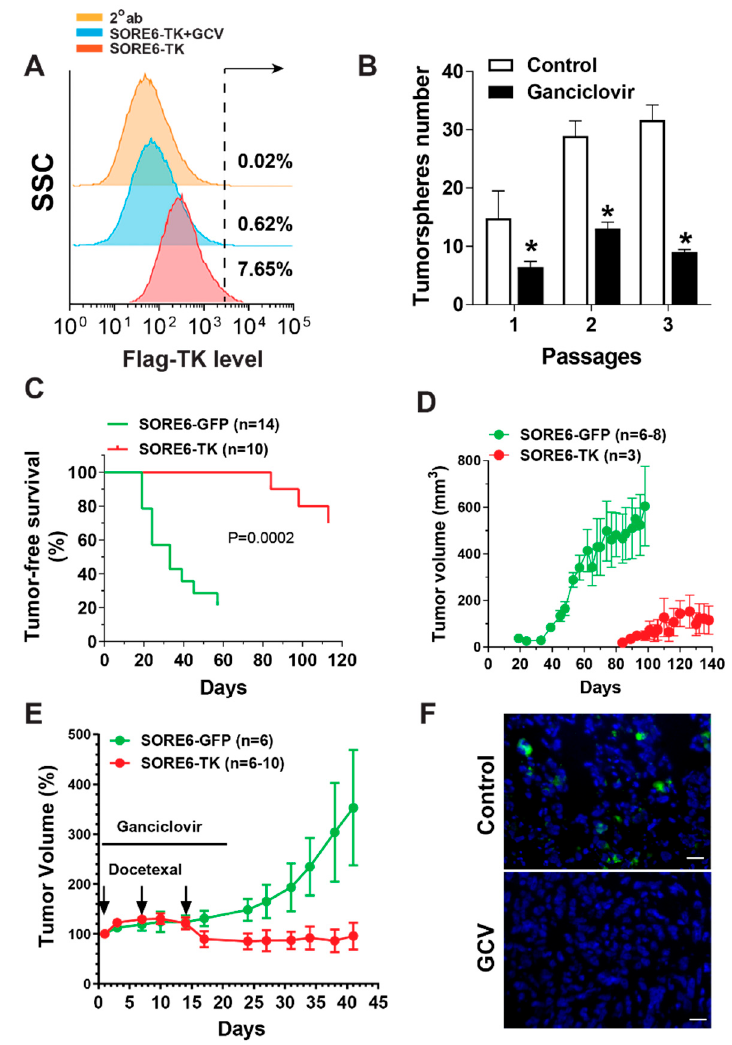
Figure 6. The ablation of SORE6 + cells blocks prostate cancer initiation and progression and enhances the therapeutic efficacy of docetaxel. ( A ) The flow cytometry analysis of SORE6-TK-expressing PC3 cells treated with ganciclovir (GCV, 10 µM) for 7 days. Cells were stained with an anti-Flag antibody followed by an Alexa488-conjugated secondary antibody or secondary antibody alone (2°ab). ( B ) The effect of GCV treatment on the tumorsphere formation of SORE6-TK-expressing PC3 cells at a series of passages. * p < 0.05 versus control, n = 3. ( C , E ) Nude mice were subcutaneously implanted with PC3 cells expressing SORE6-GFP or SORE6-TK, and either treated with GCV (25 mg/kg, i.p., daily) for 21 days immediately following implantation ( C , D ) or treated with docetaxel (15 mg/kg, i.p., once per week) in combination with GCV (25 mg/kg, i.p., daily) for 21 days when tumors reached the size of 200–300 mm 3 . The tumor growth was measured by caliper and expressed as percentage changes of the tumor volume after drug treatment. ( F ) Tumor sections were prepared from tumors derived from SORE6-TK-expressing cells and treated with or without (control) docetaxel and GCV. Sections were stained with anti-Flag antibody followed by Alexa488-conjugated secondary antibody. A representative image is shown, scale bar: 25 µ